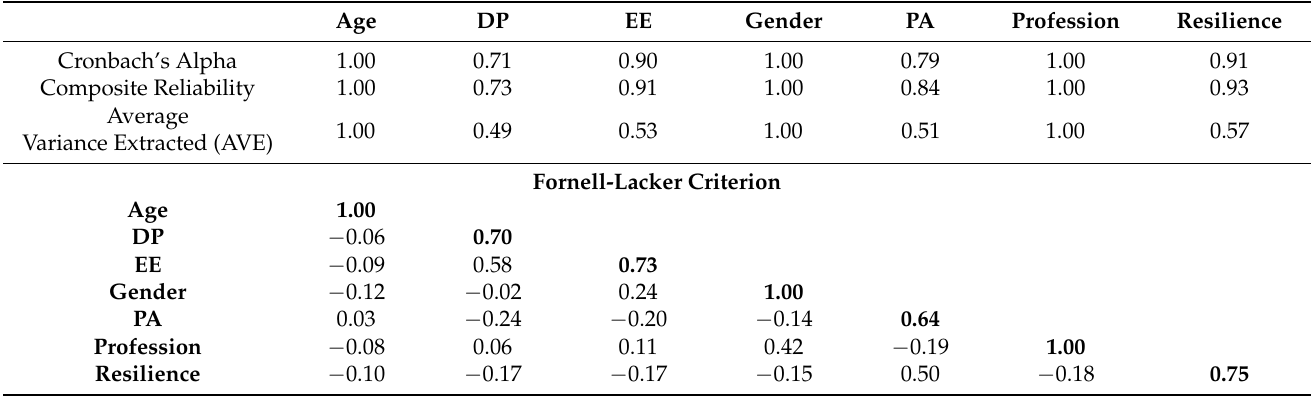
Table 1. Results of the model’s reliability, validity and discriminant measures.